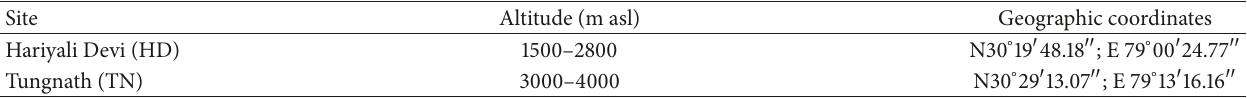
Table 1: Locations of the studied sacred groves